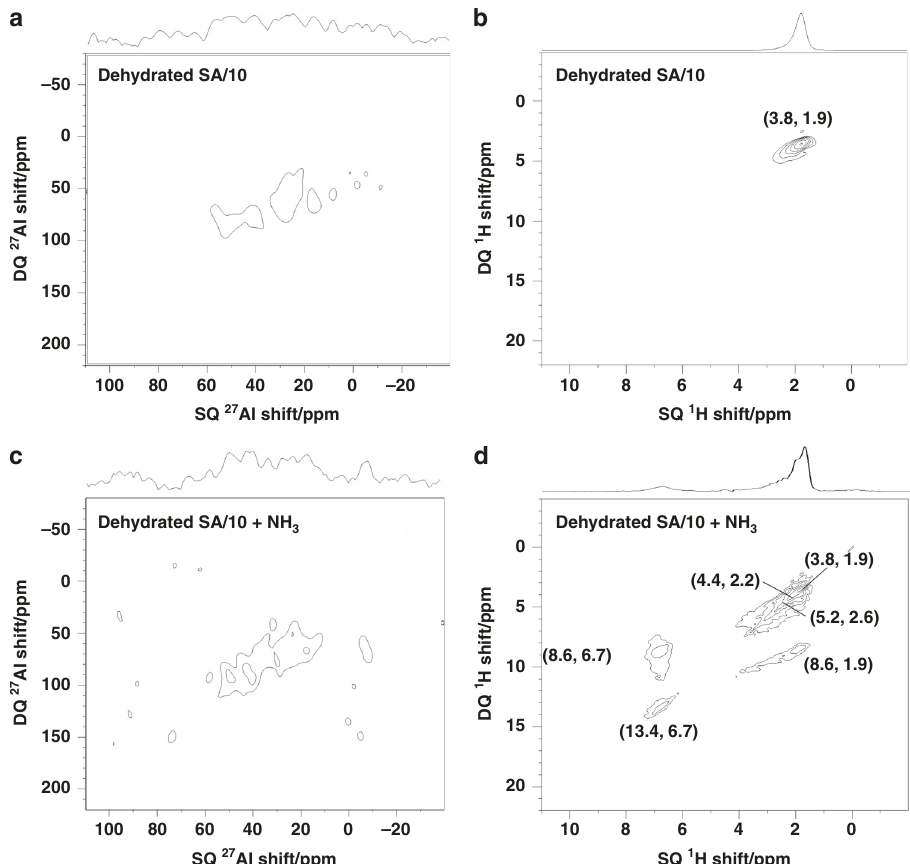
Fig. 1 DQ-SQ D -HOMCOR 2D NMR spectra of SA/10. The spectra of sub fi gures a , c and b , d are for 27 Al and 1 H NMR spectra, respectively, acquired at 18.8 T with a MAS frequency of ν R = 20 kHz. The spectra of sub fi gures a and b were acquired for SA/10 dehydrated at 723 K for 12 h under vacuum, whereas the spectra of sub fi gures c and d were dehydrated and loaded with ammonia, and then evacuated at 393 K for 1 h to remove the weakly physisorbed